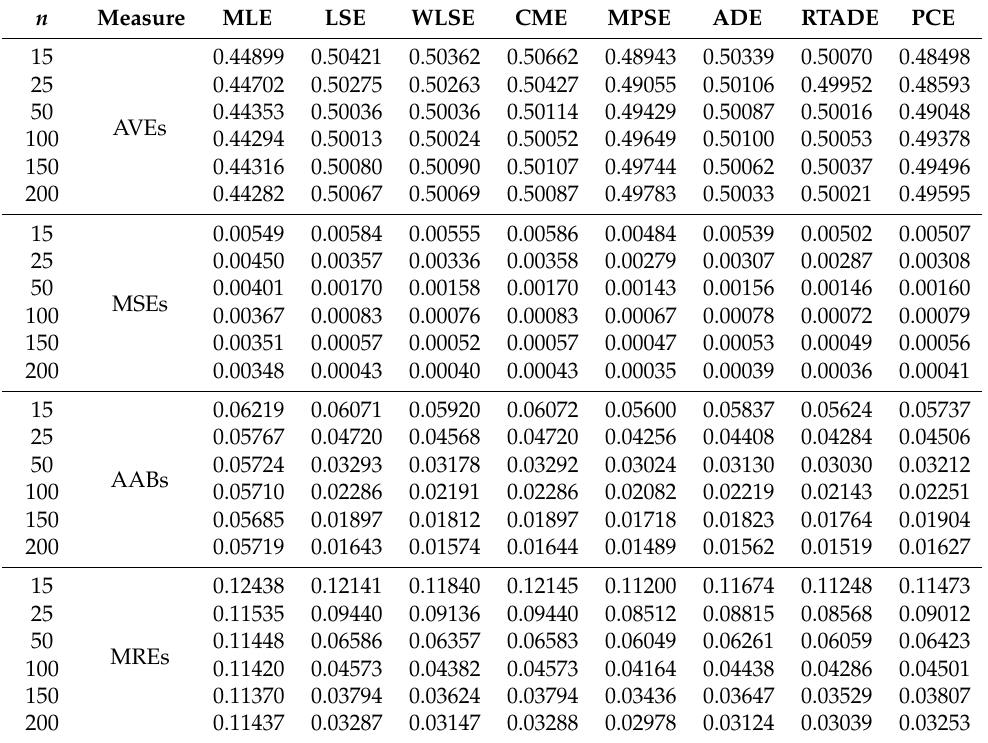
Table 4. Simulation results for the NDL distribution for θ =